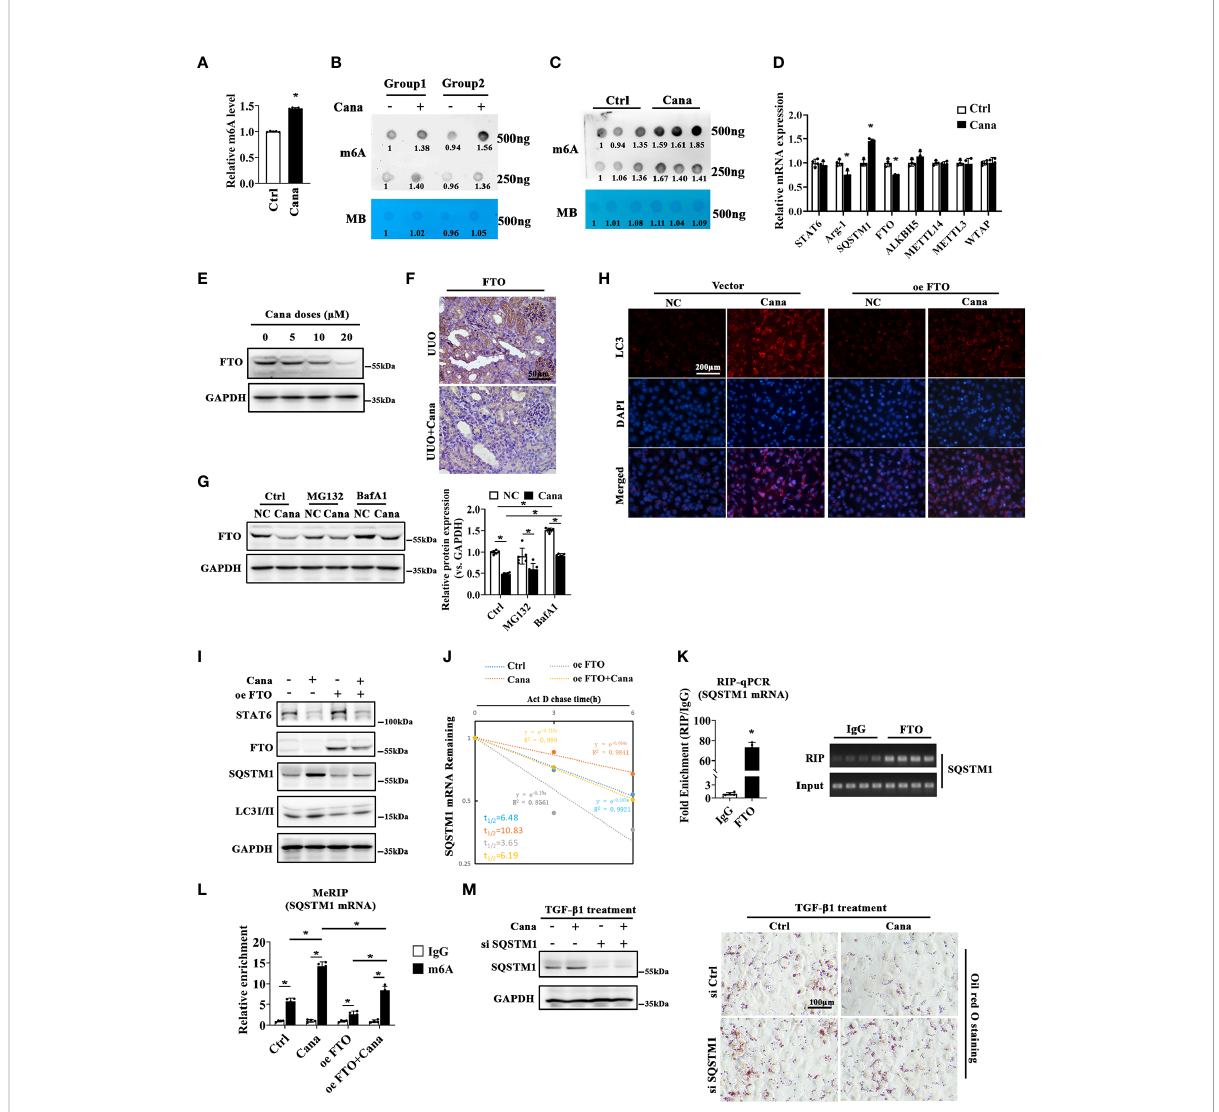
FIGURE 6 FTO was downregulated by Cana to enhance the stability of SQSTM1 mRNA through installing m6A modi fi cation of its mRNA. m6A levels of HK2 cells treated with or without Cana (20 m M) were detected by using the EpiQuik ™ m6A RNA methylation quanti fi cation kit (A) and RNA dot blot analyses (B) . Methylation blue (MB) staining served as a loading control. (C) RNA dot blot analyses of m6A levels in mice from the indicated group. (D) HK2 cells treated with or without Cana (20 m M) were harvested and subjected to qPCR to determined STAT6, Arg-1, SQSTM1, FTO, ALKBH5, METTL14, METTL3, and WTAP mRNA levels. (n = 4, * p < 0.05, Ctrl vs. Cana). (E) HK2 cells treated with Cana (0 – 20 m M) for 24 h were subjected to detected the protein levels of FTO by immunoblot analyses. (F) Mice received intragastric administration of saline or Cana (20 mg/ kg) after UUO treatment. The expression of FTO was determined through IHC staining. (G) HK2 cells were pretreated with MG132 (10 m M) or BafA1 (100 nM) for 4 h and cultured with serum-free medium for 24 h. Then, the cells were left and treated with or without Cana (20 m M) for another 24 h. Immunoblot analyses was performed to detect the protein level of FTO. (H – J, L) HK2 cells were transfected with or without plasmid of FTO overexpression 48 h. Then, cells were treated with or without Cana (20 m M) for another 24 h. (H) The levels of LC3 in HK2 cells from the indicated group were detected through immuno fl uorescence staining. (I) Immunoblot analysis was performed to determine the protein levels of STAT6, FTO, SQSTM1, LC3I/II, and GAPDH. (J) qPCR analyses of SQSTM1 mRNA stability in HK2 cells from the indicated group (* p < 0.05). (K) RNA immunoprecipitation (RIP)-qPCR analyses revealed the SQSTM1 mRNA level enriched by the FTO antibody. The agarose gel electrophoresis analyses of qPCR products are shown on the panel (* p < 0.05). (L) MeRIP-qPCR assay indicated the m6A modi fi cation level of HK2 cells from the indicated group (* p < 0.05). (M) HK2 cells transfected with or without SQSTM1 siRNA for 24 h and then treated with Cana (20 m M) along with TGF- b 1 (5 ng/ml) for another 48 h. The ef fi ciency of knockdown SQSTM1 in HK2 cells was con fi rmed by immunoblot analyses. Representative microphages showed the Oil Red O staining in HK2 cells with indicated